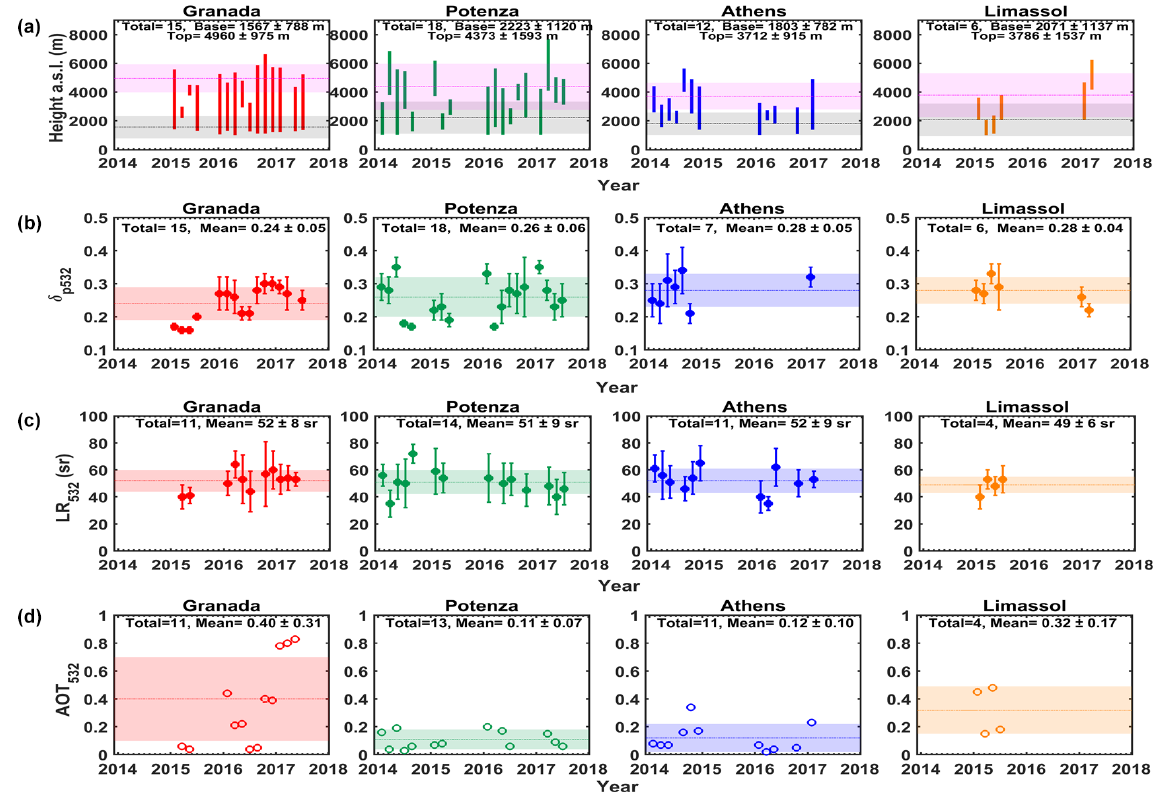
Figure 4. Mean values along with the standard deviation of (a) the base and the top, (b) δ p532 , (c) LR 532 and (d) AOT 532 , per station (text and banded lines) and per case (symbols and error bars) within the observed dust